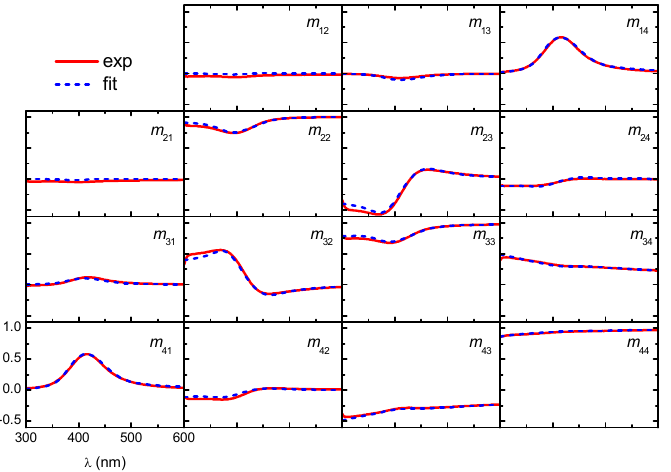
Figure 4. Experimental Mueller matrix in transmission mode at normal incidence. The fit corresponds to Tellegen constitutive equations.